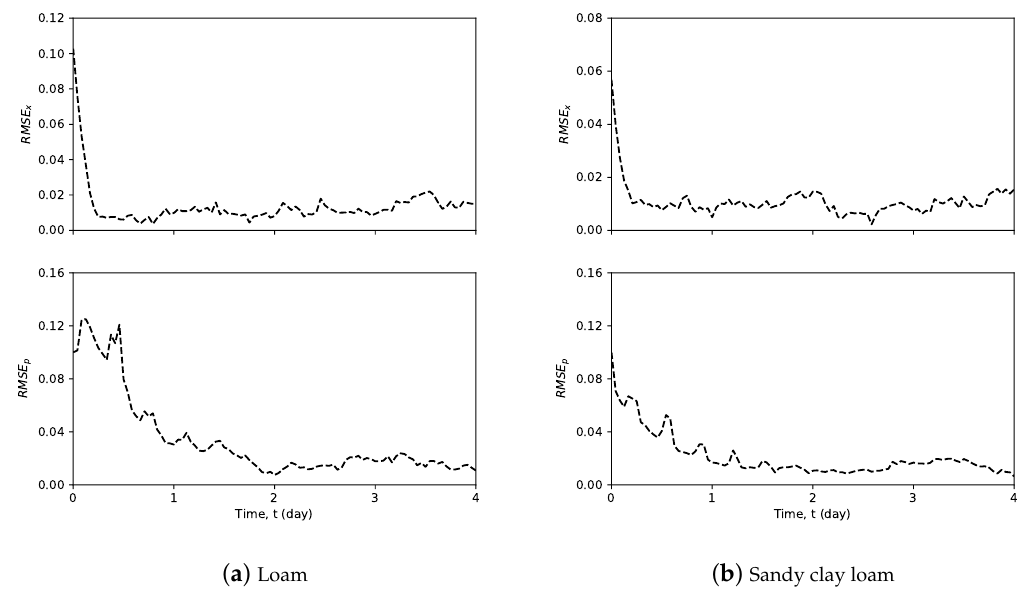
Figure 8. Trajectories of RMSE measuring the estimation performance of DeMHE for studying impact of initial conditions (Scenario